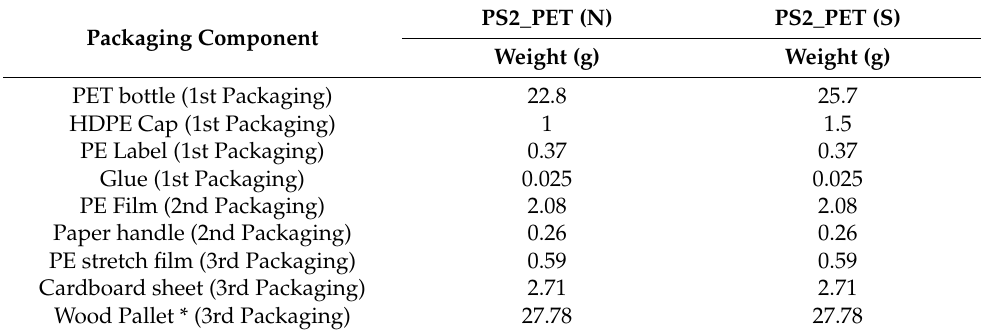
Table 2. Weight and composition of all components of the PS2_PET (N) and PS2_PET (S) systems. Packaging